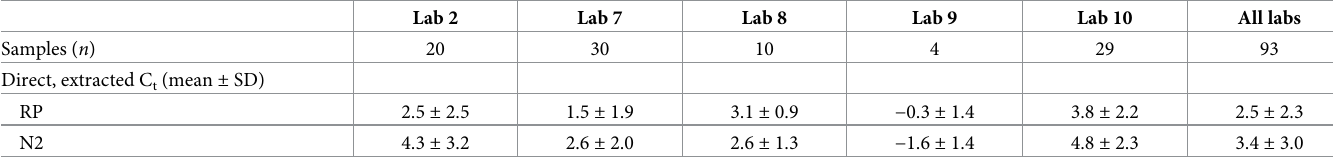
Table 3. Difference in sensitivity of direct RT-PCR and extraction RT-PCR methods on local samples from five